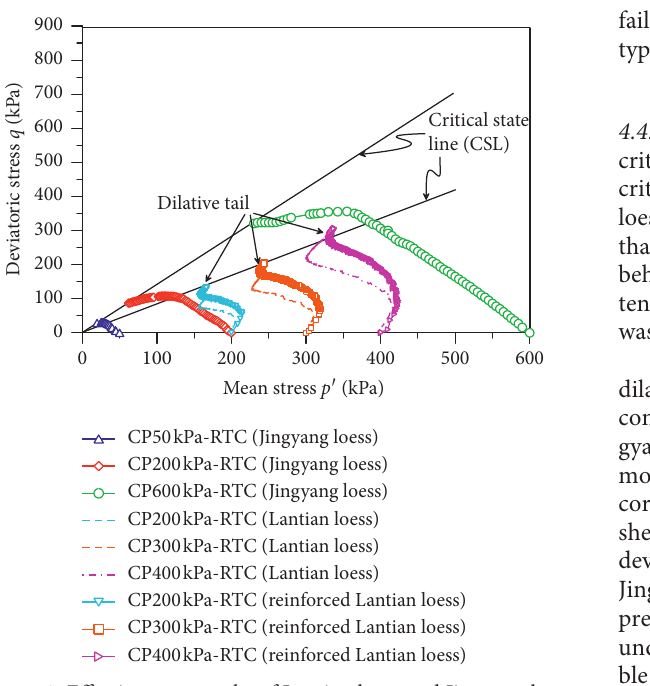
Figure 8: Pore pressure response of Delhi silt under the RTE stress path: (a) pore pressure u versus axial strain ε strain ε a .